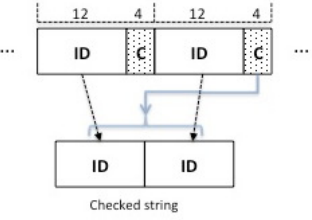
Figure 2. Example of using of a chaining check